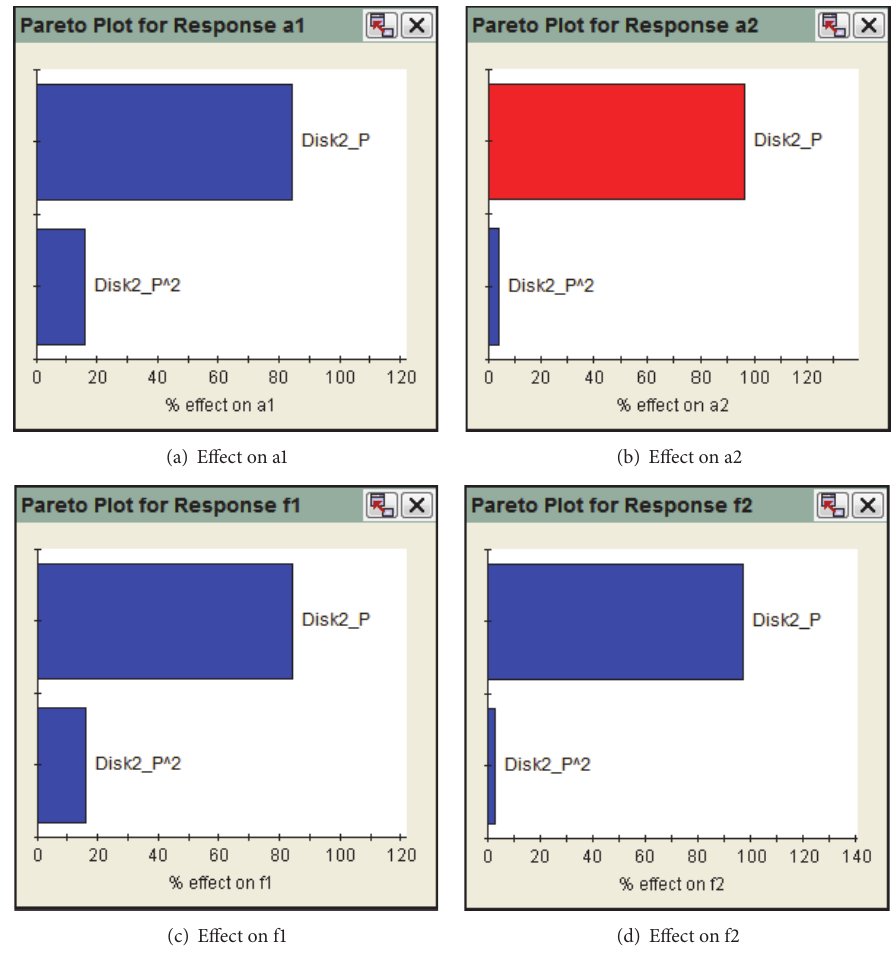
Figure 7: Effect of changing Disk2 P on optimization objectives.